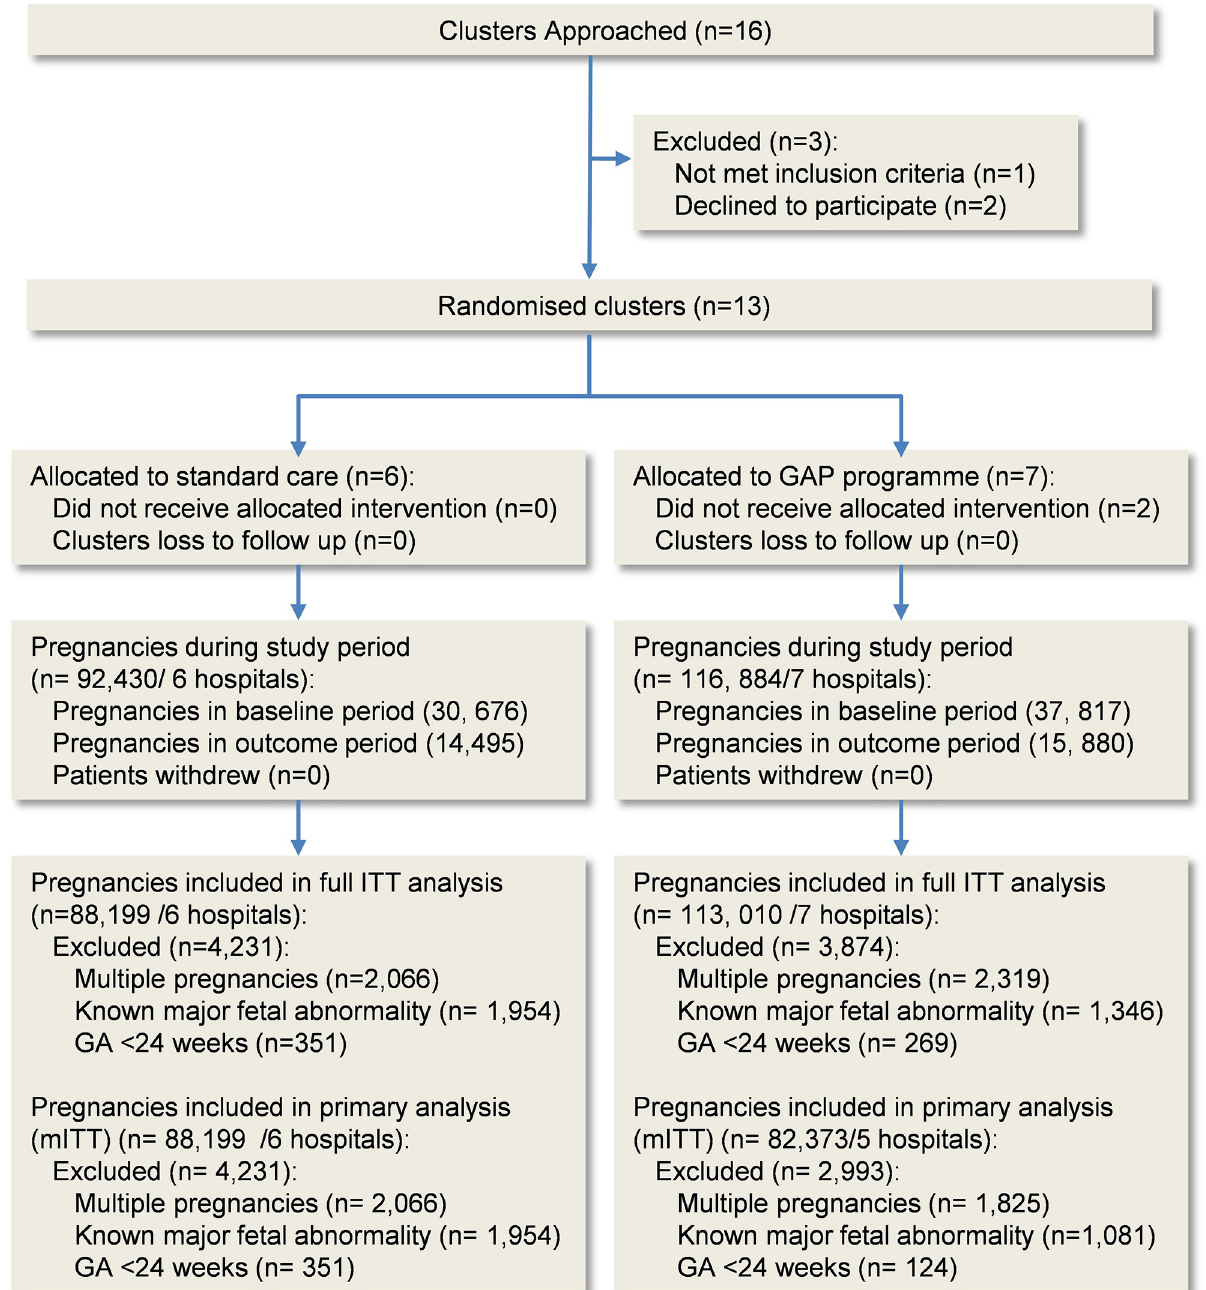
Fig 1. Study population (CONSORT flow diagram). GAP, Growth Assessment Protocol; ITT, intention to treat; mITT, modified intention to treat. deprived) quintile of Index of Multiple Deprivation (7.6% versus 17.4%) in the intervention arm than the standard care arm. Similar findings were observed in the outcome period. Demo- graphic characteristics were also broadly similar using available case data (for variables that were imputed) and the ITT sample (13 clusters) (Tables A and B in S3 Appendix). A